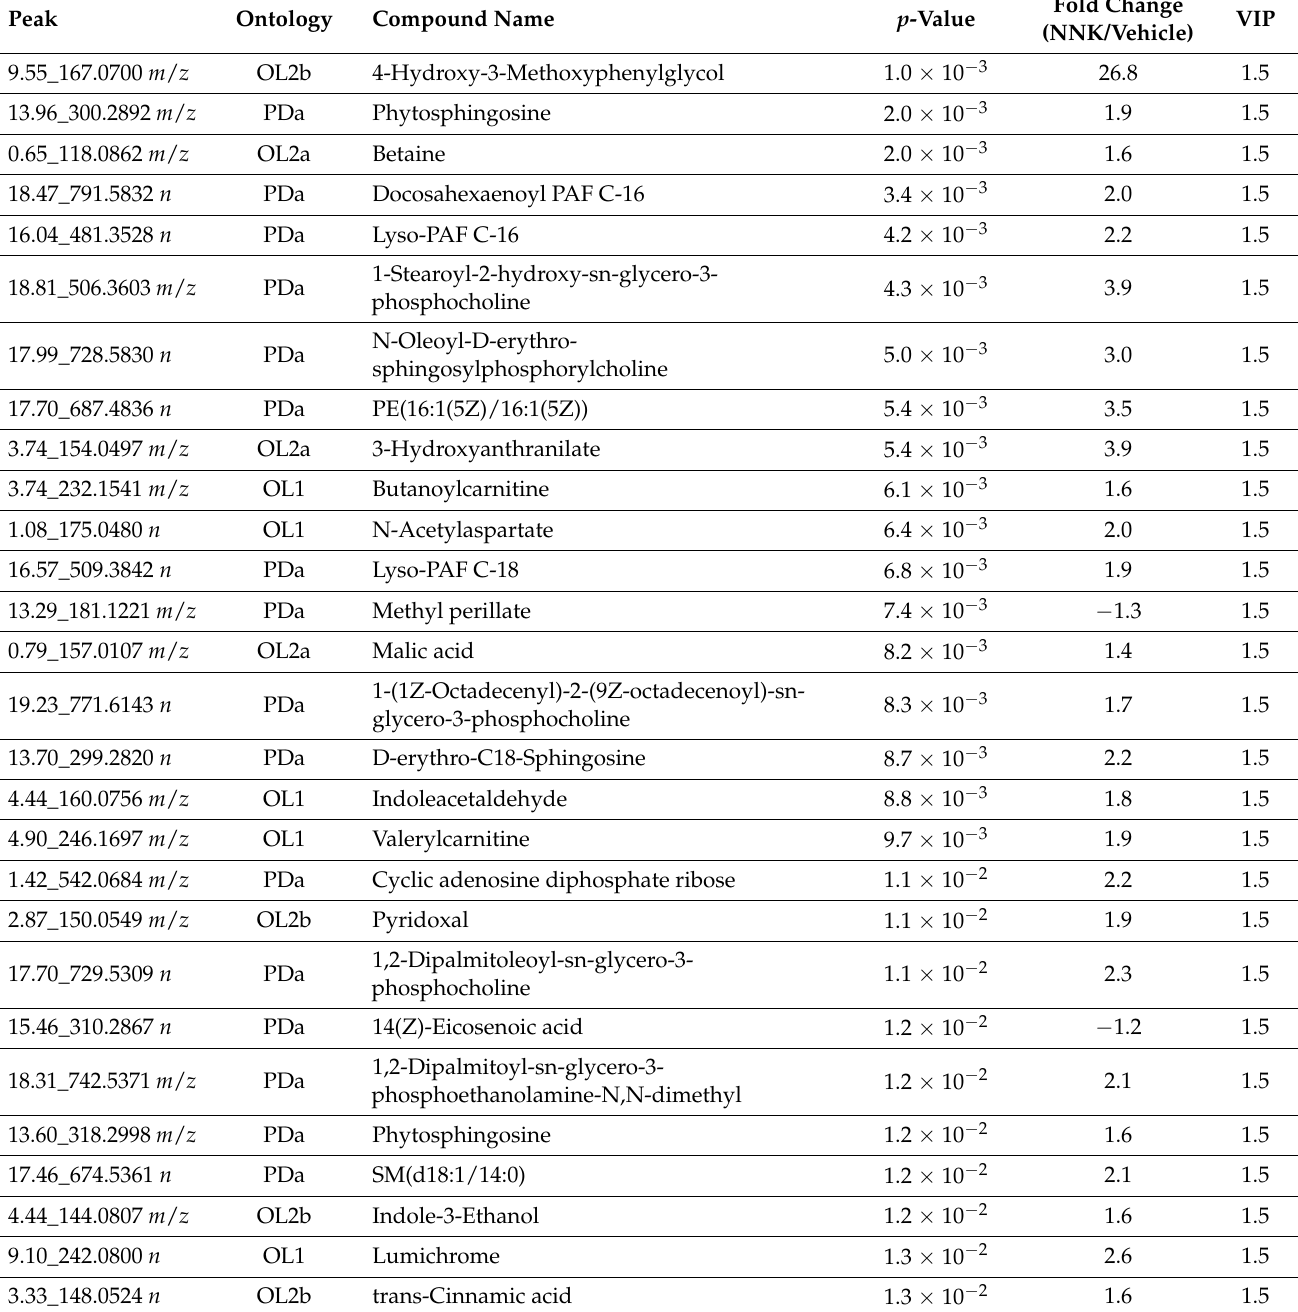
Table 8. Top 50 significantly altered metabolites between CAL27 cells treated with NNK or